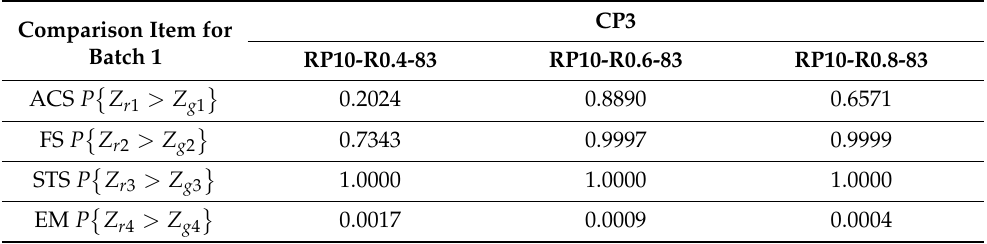
Table 7. Probability that the CVMC for steel fiber concrete is greater that of concrete for batch 1. Comparison Item for